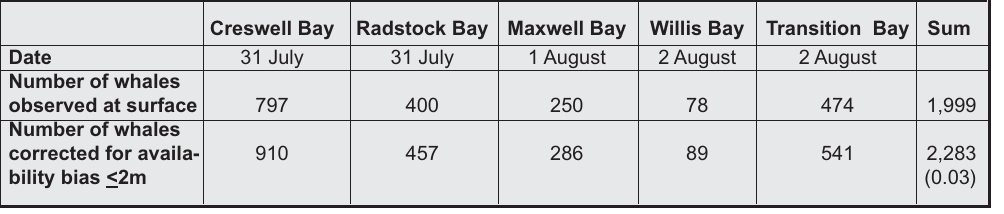
Table 2. Counts of belugas in estuaries. The corrected number of whales is corrected for an esti- mate of availability bias of 87.5 % at 0 to 2 m (cv=0.032). Coefficient of variation is shown in